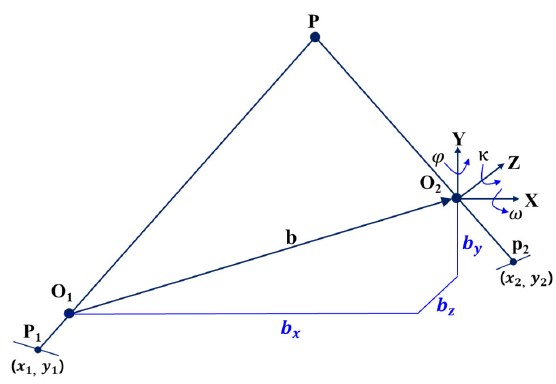
Figure 2. Geometry of the coplanarity for relative orientation.